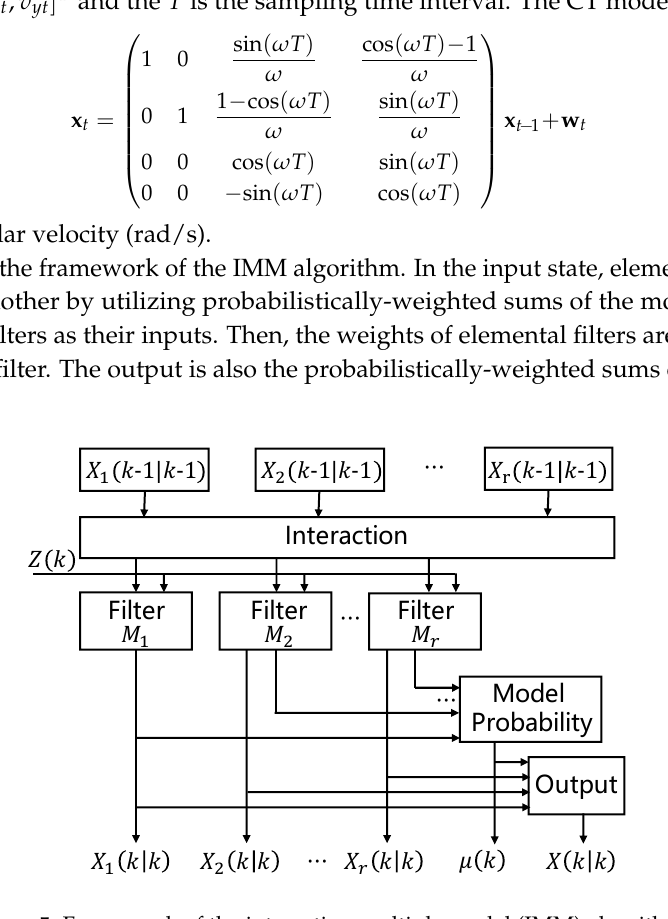
Figure 5. Framework of the interacting multiple model (IMM)